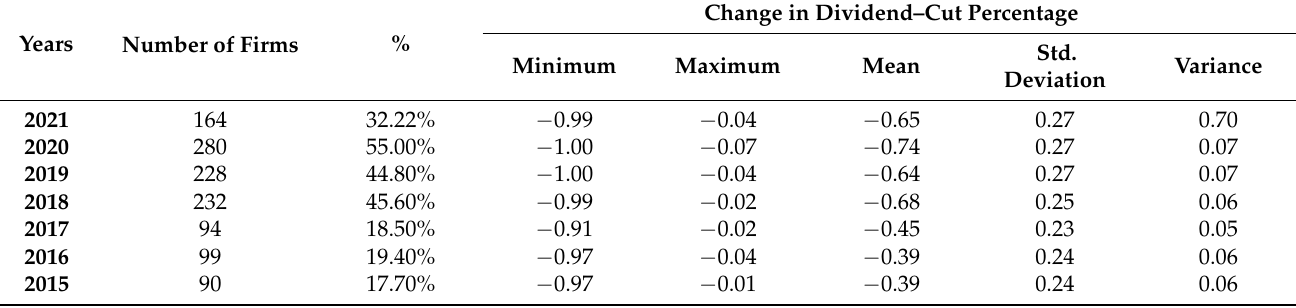
Table 4. Pattern of dividend cuts 2015